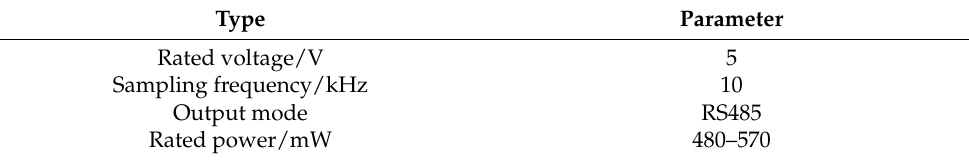
Figure 4. Diagram of inertia sensor and navigation system. ( a ) Navigation reference station; ( b ) posture sensor. Table 4. Parameters of inertia sensor.